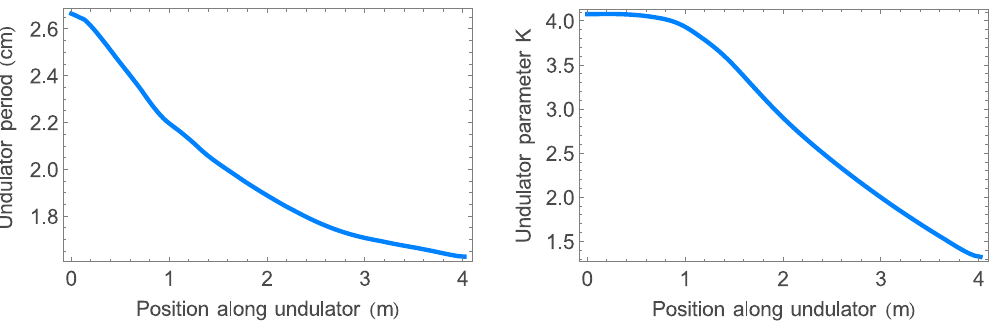
FIG. 6. Undulator period (left) and normalized undulator amplitude (right) as a function of undulator length for the reference 50 GW input seed power